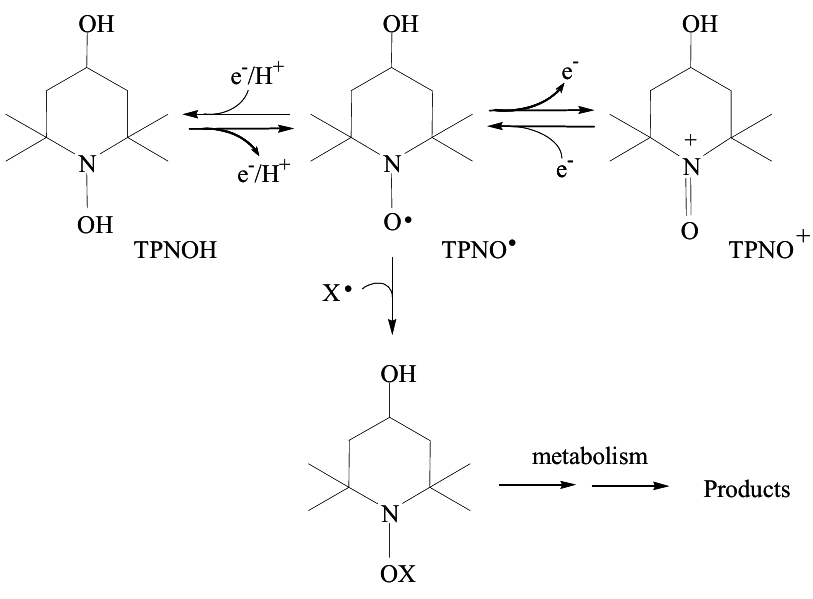
Fig. 1 – Main biological redox reactions of tempol (TPNO • ) , a cyclic nitroxide of the six-membered piperidine class. In addition to the reversible redox reactions, tempol is consumed by recombination reactions with alkyl, alkoxyl, tyrosyl and thiyl radicals. The latter are likely to be important in nitroxide metabolism (Borisenko et al.